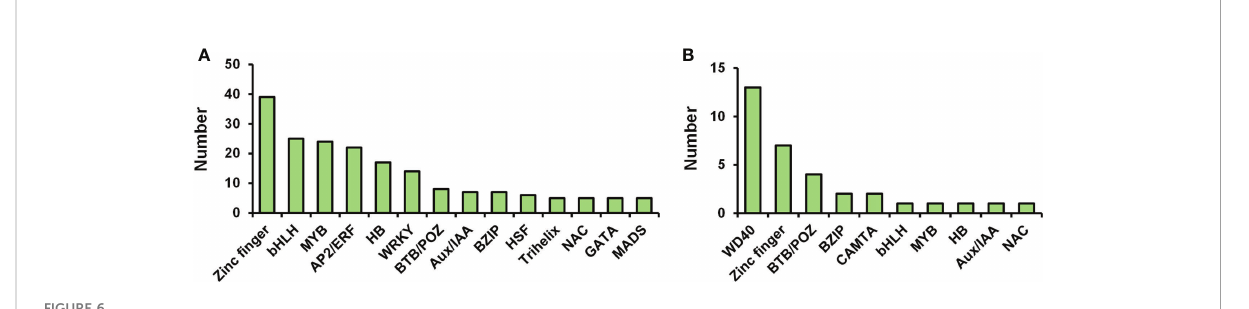
FIGURE 6 Distribution of transcription factors in transcriptome (A) and proteome (B)